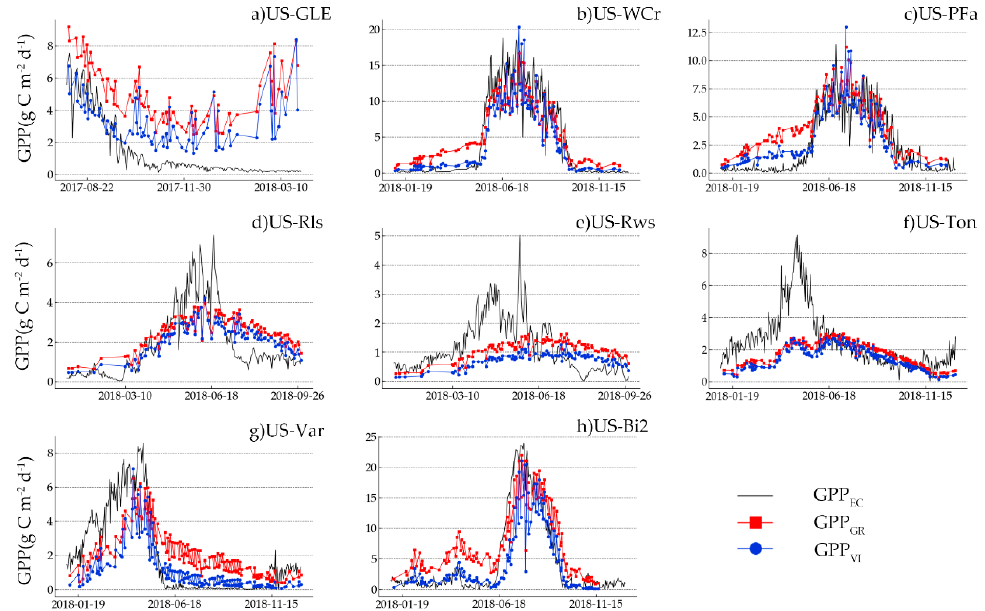
Figure 7. GPP GR , GPP VI , and GPP EC temporal dynamics for all sites in 2017–2018. ( a – h ) represent the site the same as Figure 4. Table 6. Coefficient of determination (R 2 ), root mean square error (RMSE, gC/m 2 /d ) and bias (gC/m 2 /d) for GPP GR , GPP VI , and GPP EC .